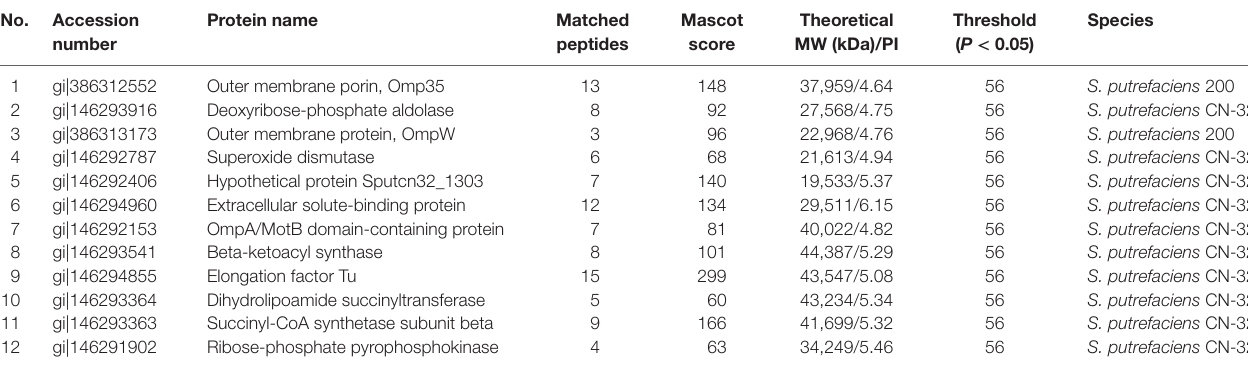
TaBle 2 | The mass spectrometry result of different proteins from S. putrefaciens in freshwater and sewage. no. accession